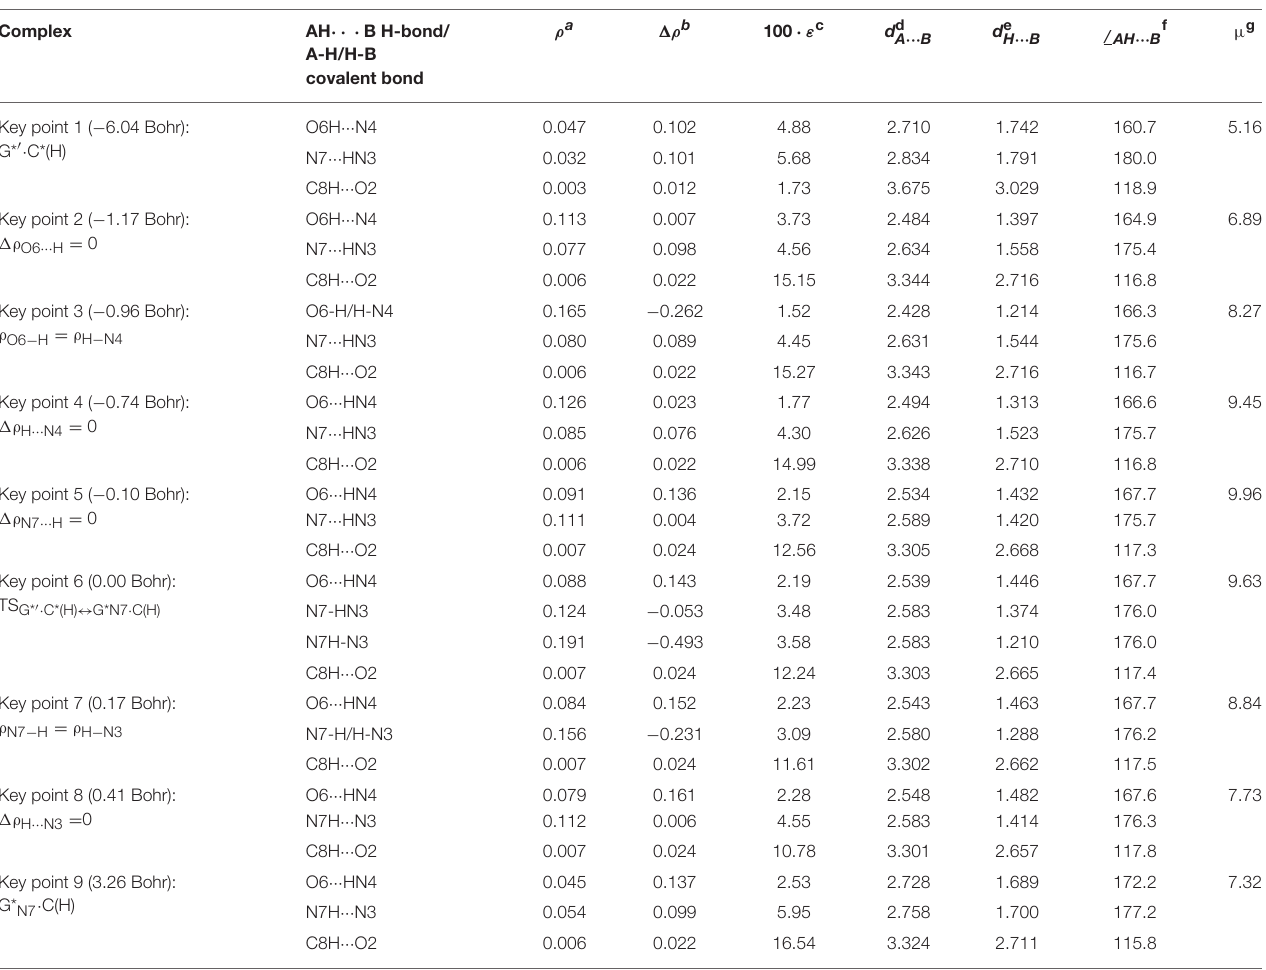
TABLE 6 | Electron-topological and structural characteristics of the specific intermolecular bonds revealed in the 9 key points and the polarity of the latters along the IRC of the IV. G* ′ C*(H) G* N7 C(H) tautomerisation obtained at the B3LYP/6-311 · ↔ ·